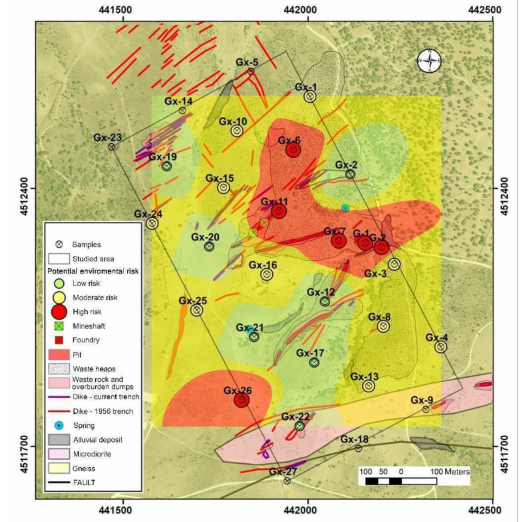
Figure 6. Qualitative assessment of environmental risk